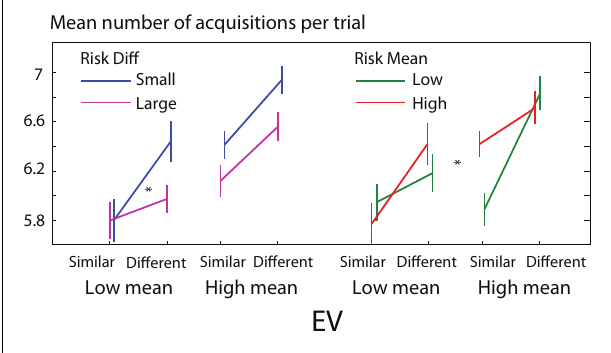
FIGURE 11 | Participants make more acquisitions on trials where the mean EV of the two gambles is low, and when the two EV s are similar (higher difficulty). The presence of a large risk difference reduces the difficulty effect (interaction p < 0 . 05). High mean risk increases the